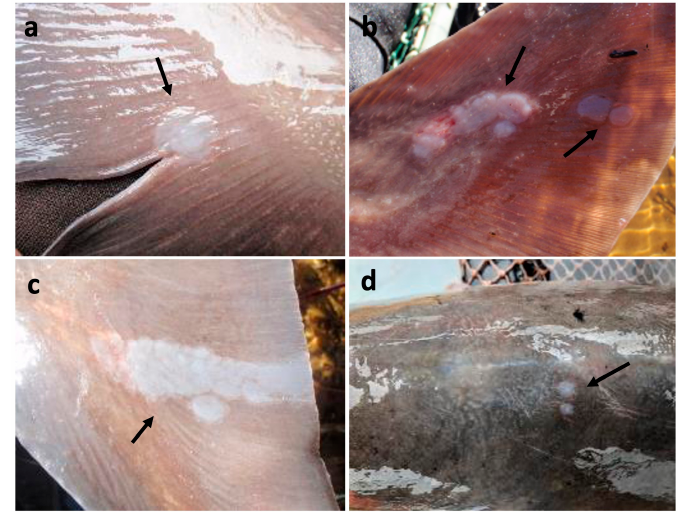
Figure 1. Semi-translucent to opaque, whitish, slightly raised plaque-like skin lesions observed on adult lake sturgeon in the Black ( a , c ) and St. Clair ( d ) Rivers indicated with black arrows. Lesion intensity varied from focal ( a ) to multifocal ( d ), to multifocal and coalescing ( b , c ) on the skin of the fins, head, and body. Table 2. Biometric, lesion prevalence, and packed cell volume (PCV, σ = Standard deviation) data collected from adult lake sturgeon in year one and two from 2 rivers within the Lake Huron (LH) and Lake Erie (LE) watersheds. Means and ranges are shown for biometric data.